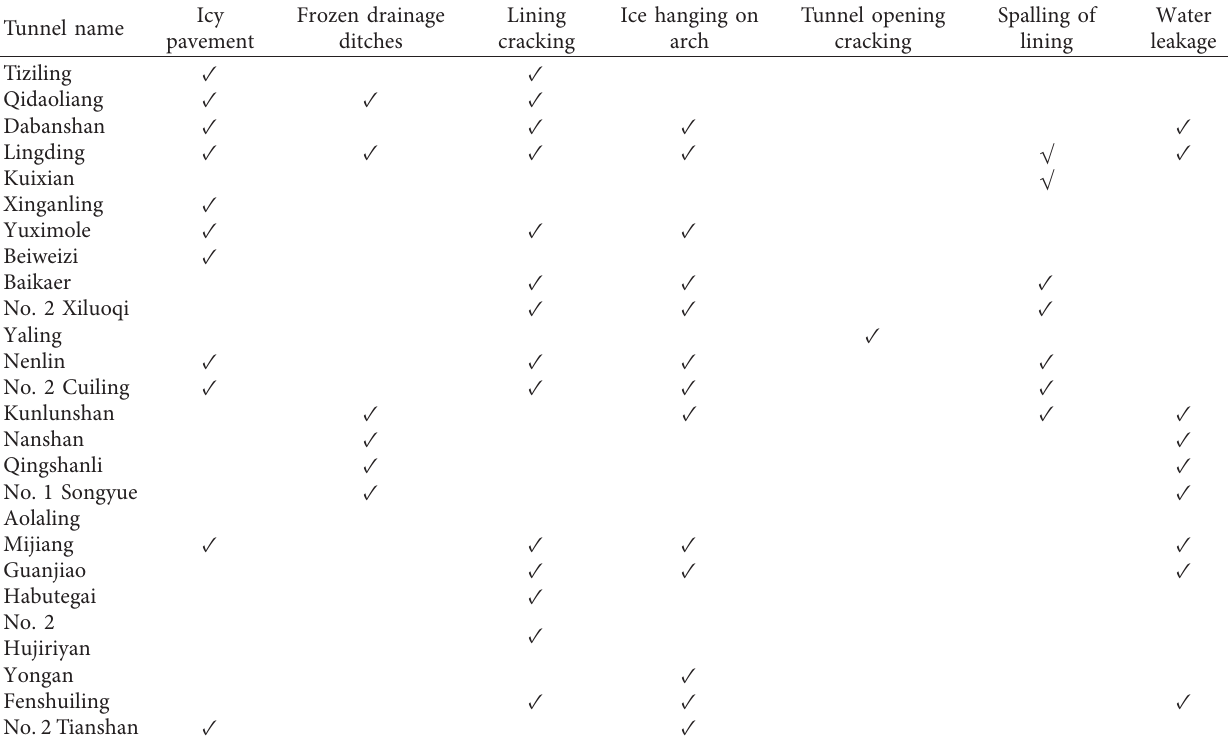
Table 1: Frost damage characteristics in permafrost tunnels